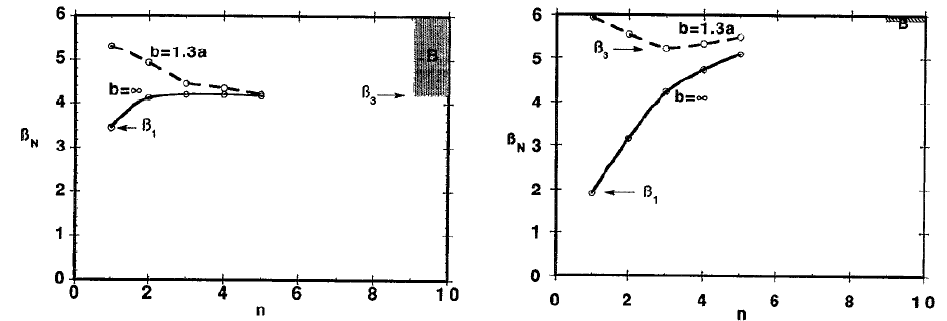
Figure 29. Comparison of beta limit with and without wall stabilization for positive shear regime q(0)~1 (left) and negative shear regime (right) by Manickam